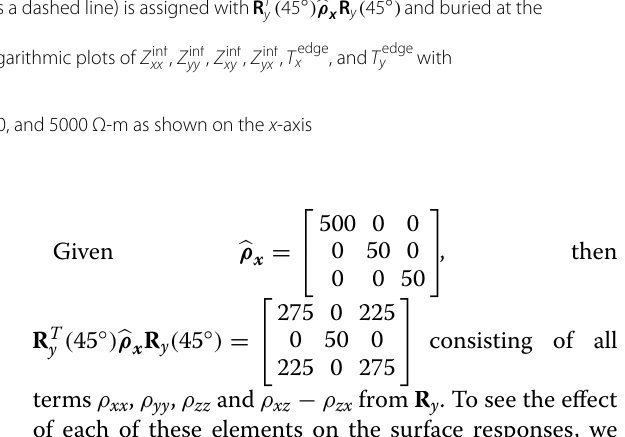
ρ x R y ( 45 ◦ ) and buried at the (cid:31)